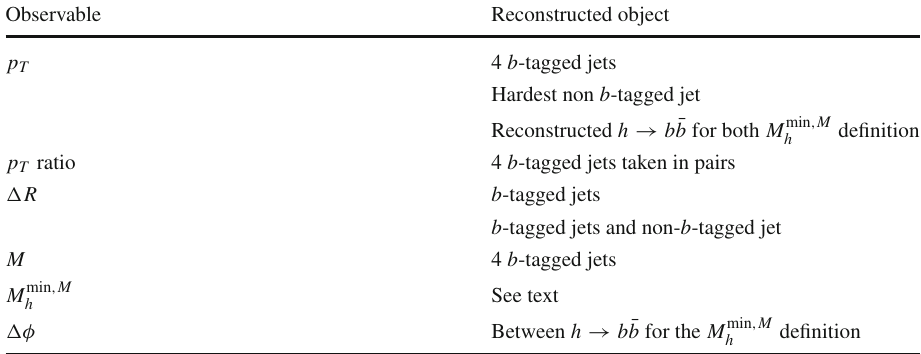
Between h → b ¯ b for the M min , M definition h with λ = λ SM . Numbers to the left of the double vertical lines are in